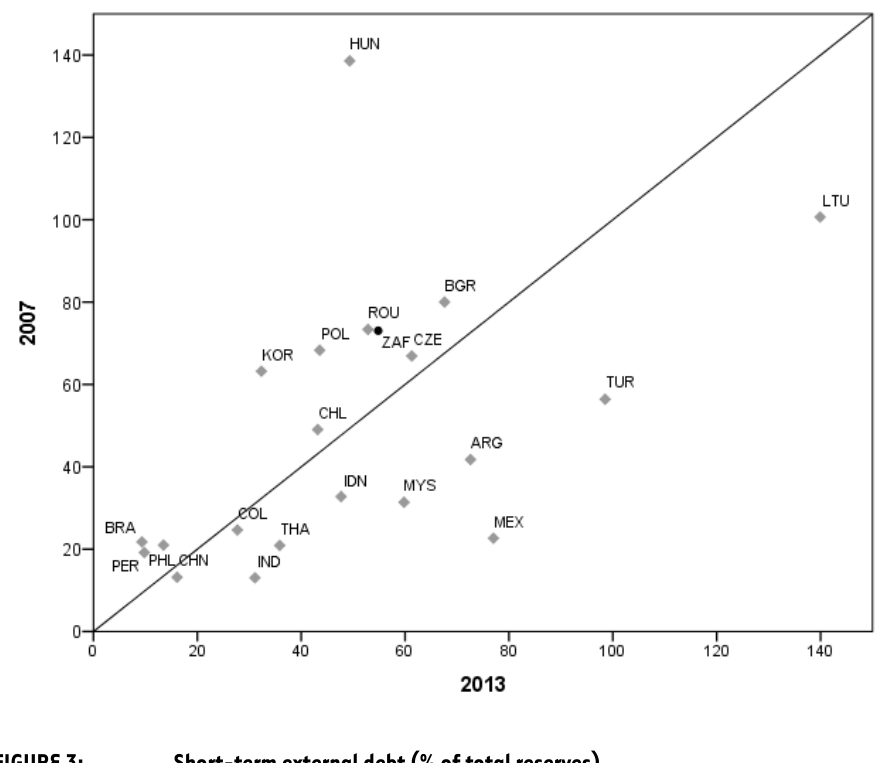
FIGURE 3: Short-term external debt (% of total reserves)